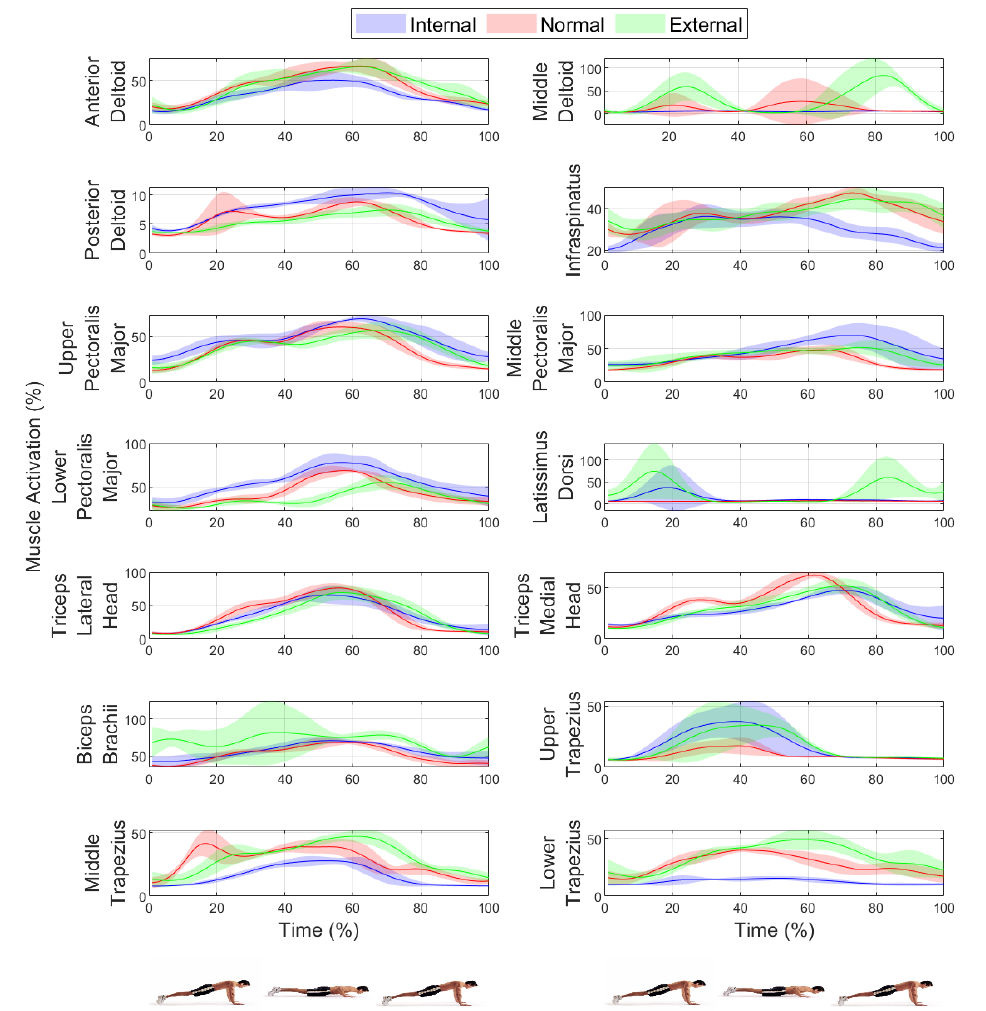
Figure 4. The mean and standard deviation of muscle activities for 14 muscles: the anterior deltoid, middle deltoid, posterior deltoid, infraspinatus, upper pectoralis major, middle pectoralis major, lower pectoralis major, latissimus dorsi, triceps lateral, triceps medial, biceps brachii, upper trapezius, middle trapezius, and lower trapezius muscles during the push-up exercise in three rotational positions of palms (90 internal rotation, 0 rotation, and 90 external